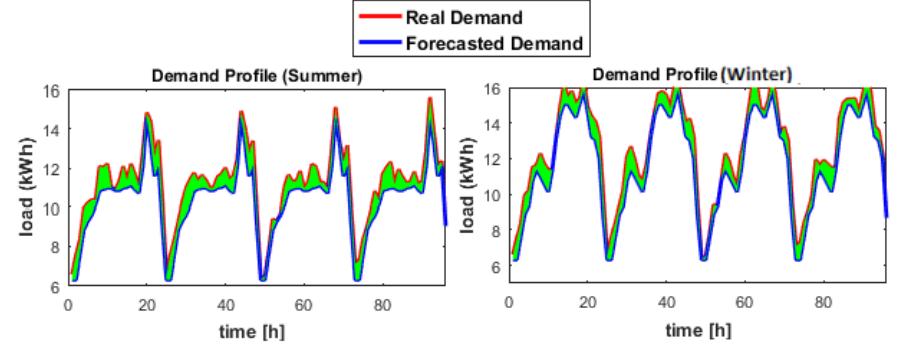
Figure 3. Load demands